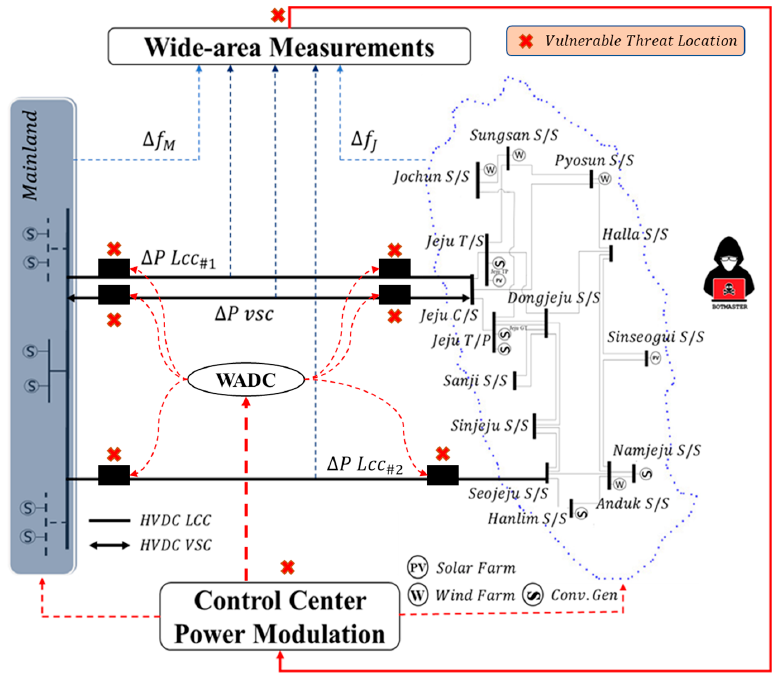
Figure 2. Several vulnerable point attack in MIDC